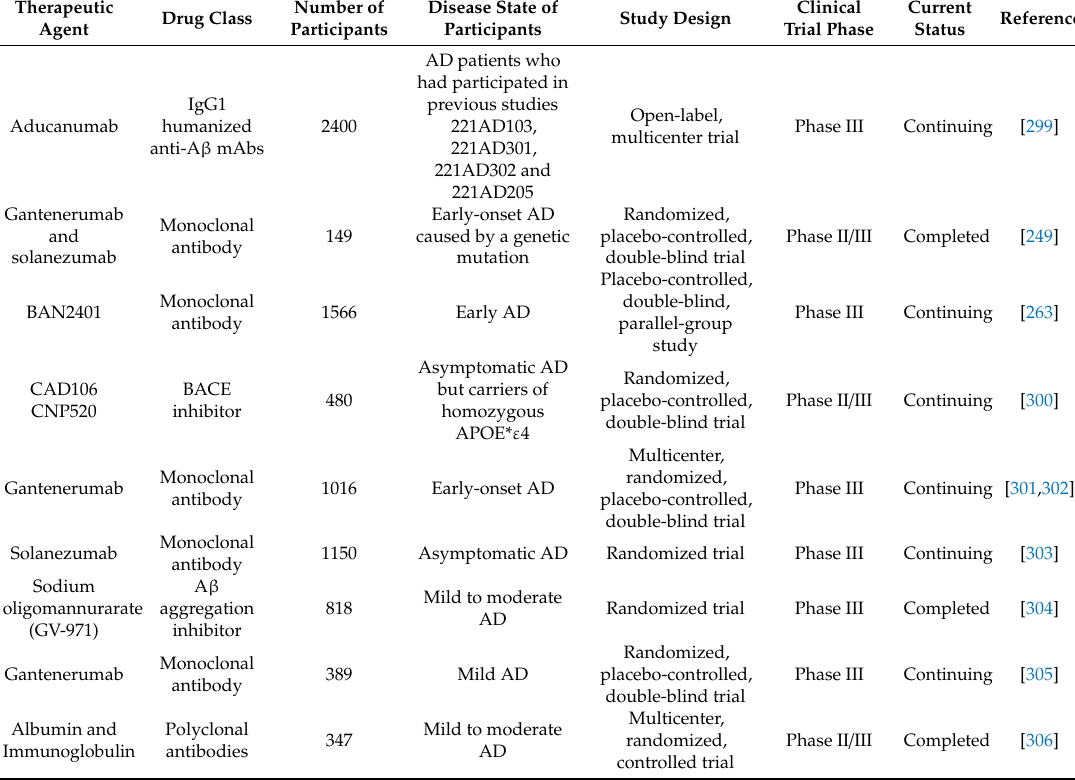
Table 2. Ongoing clinical studies of anti-A β therapeutics to treat Alzheimer’s